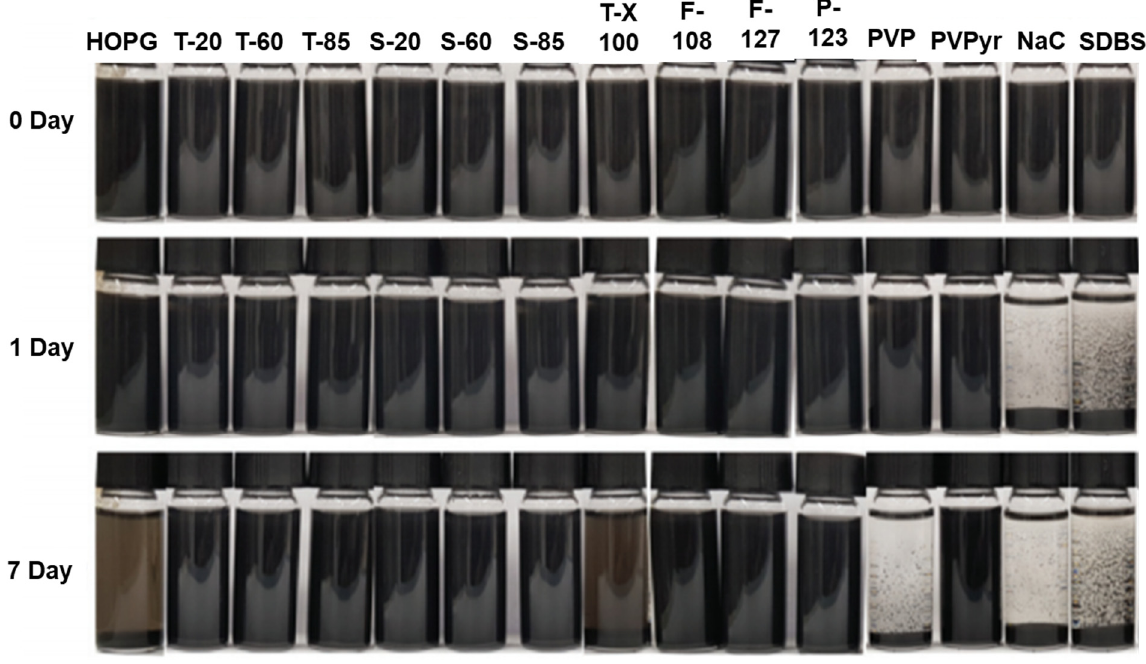
Figure 5. Photographic images of graphene dispersions with different surfactants in NMP. Reproduced from [84]. HOPG: highly pyrolytic graphite; T-20, T-60, and T-85: Tween series; S-20, S-60, and S-85: Span series; T-X100: TritonX-100; F-108, F-127, and P-123: pluronic surfactants; PVP: Poly(4-vinyl pyridine); PVPyr: poly(vinyl pyrrolidone); NaC: sodium cholate; SDBS: sodium dodecyl benzene sulfonate.